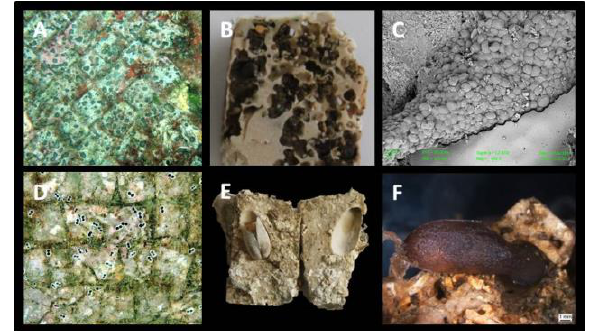
Fig. 2. A - Section of a mosaic tessera with an evident Fig. 1. A - Mosaic floor colonized by boring sponges; B - colonization caused by microflorabiota (green layer); B - Section of a mosaic tessera bioeroded by boring sponges; C – Microboring burrows inside marble crystals (transmitted light SEM microphotograph of a resin cast clionaids sponge; D microscopy); C - SEM microphotograph of microborings; D - Mosaic colonized by the bivalve Rocellaria dubia ; E - – microphotograph of endolithic microflorabiota cast Mosaic tesserae with specimen of Rocellaria dubia inside its burrow; F - The boring sipunculans Aspidosiphon muelleri .